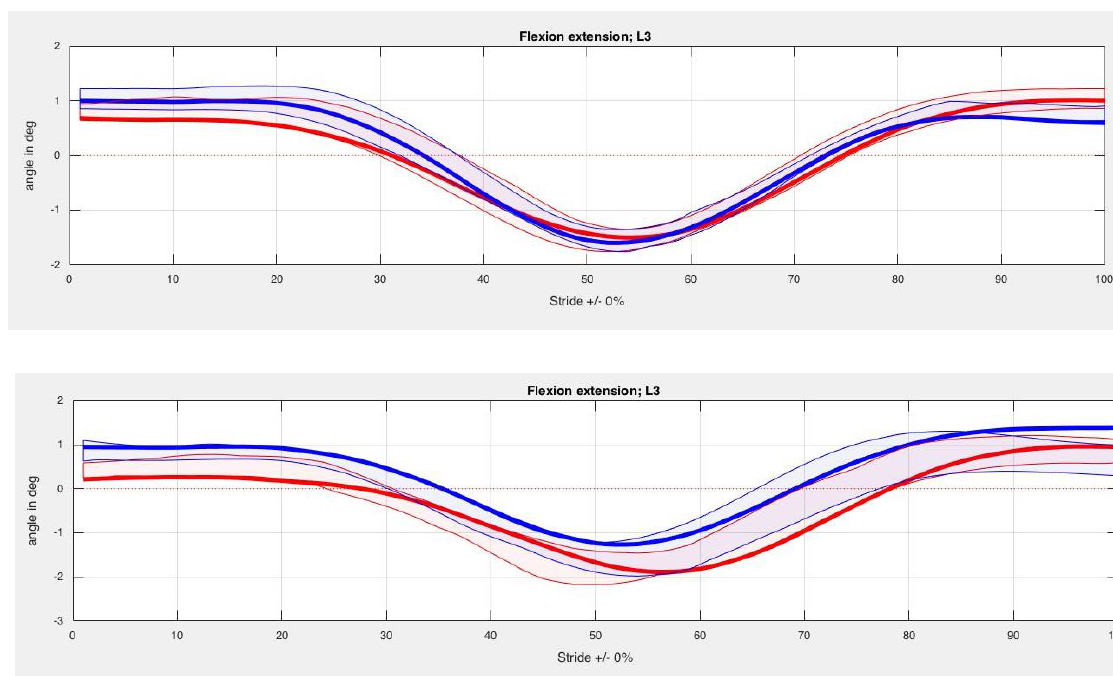
the mean, shaded area the standard deviation. Left hindlimb red and right hindlimb blue.